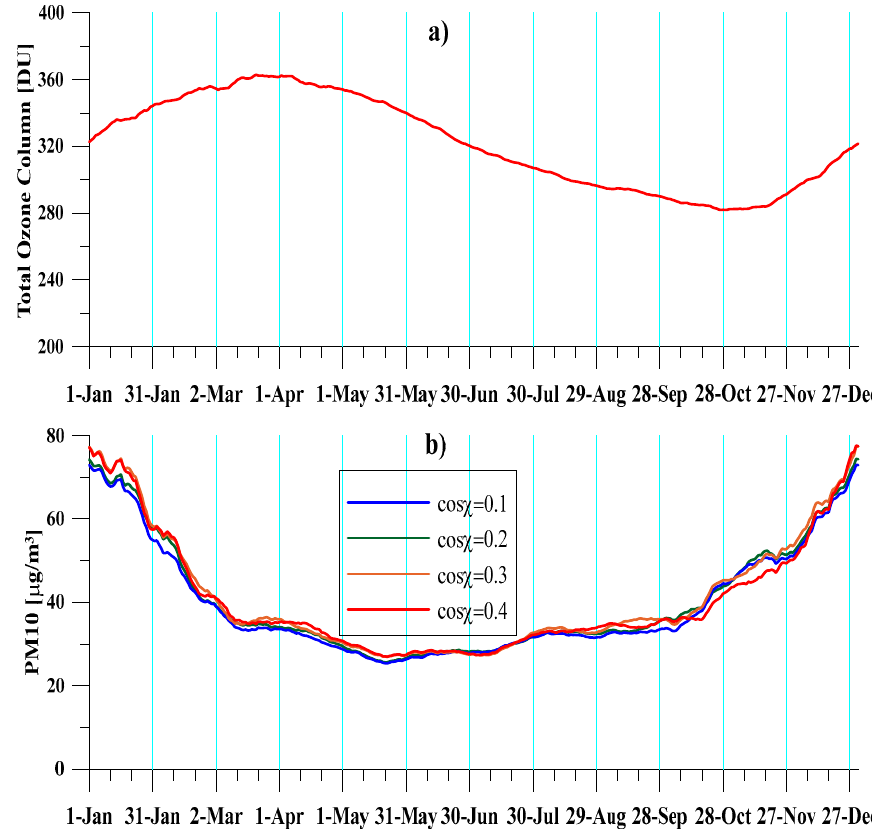
Figure 8. ( a ) Average seasonal behavior of the TOC over Sofia and ( b ) average seasonal variability of the concentration of PM10. the concentration of